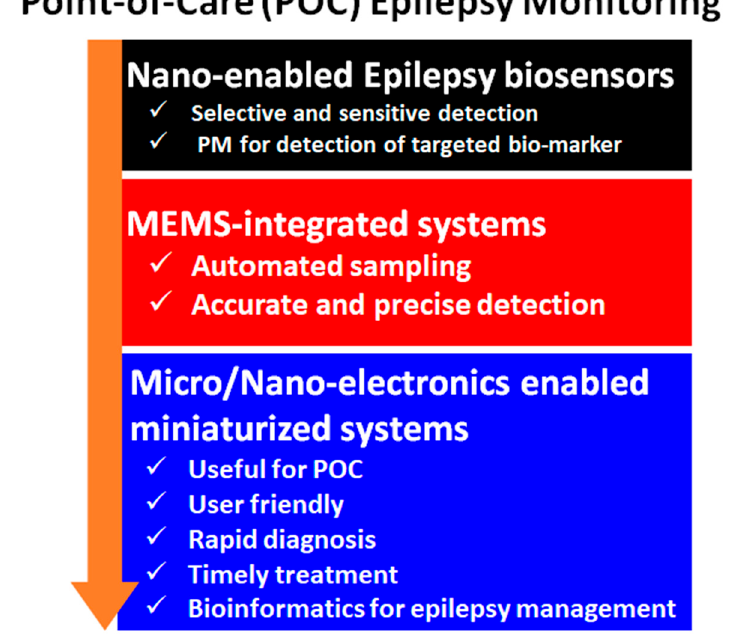
Figure 8. Illustration of future epilepsy biosensing technology in order to monitor epilepsy at POC application. (PM = personalized medicines).